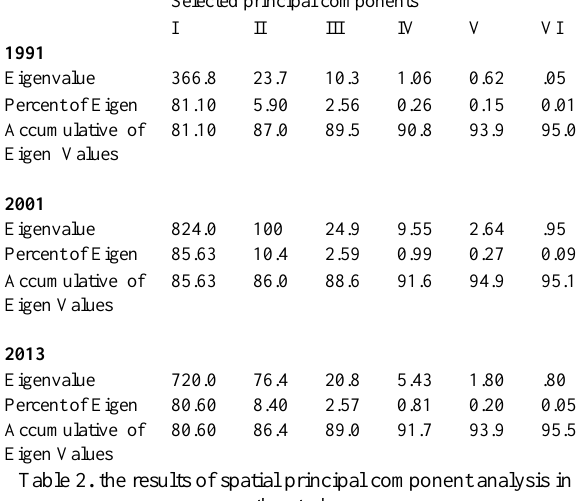
Table 2 . the results of spatial principal component analysis in the study